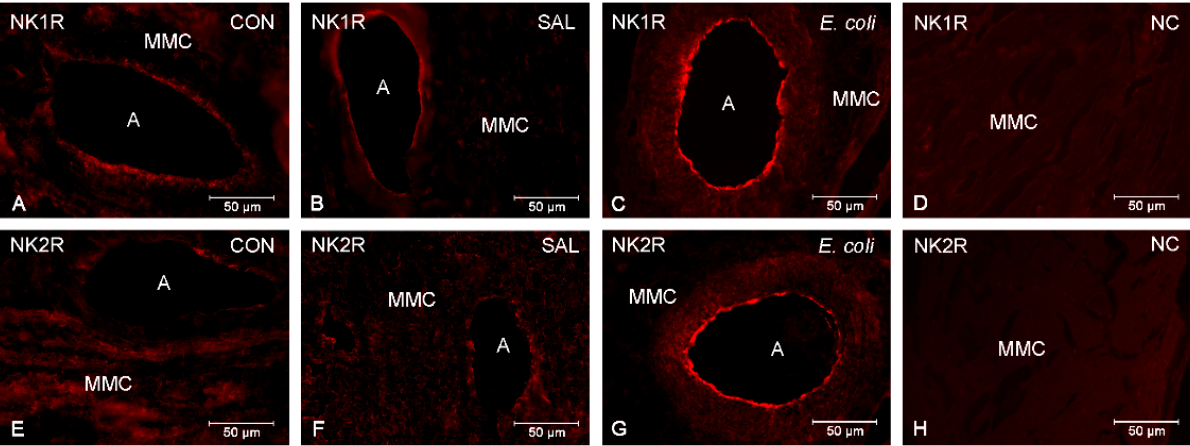
Figure 2. Representative pictures of NK1R ( A – C ) and NK2R ( E – G ) in the myometrium of gilts from the control (CON), saline (SAL) and E. coli (E. coli) groups. Positive immunoreaction to NK1R is visible in myometrial muscular cells (MCM) and arteries ( A ) of the control ( A ), saline-( B ) and pathogens ( C )-injected uteri. Expression of NK2R display MCM and A in the control ( E ), saline-injected ( F ) and inflamed ( G ) uteri. Negative control (NC) for NK1R ( D ) and NK2R ( H ) was obtained following the use of rabbit normal IgG instead of primary